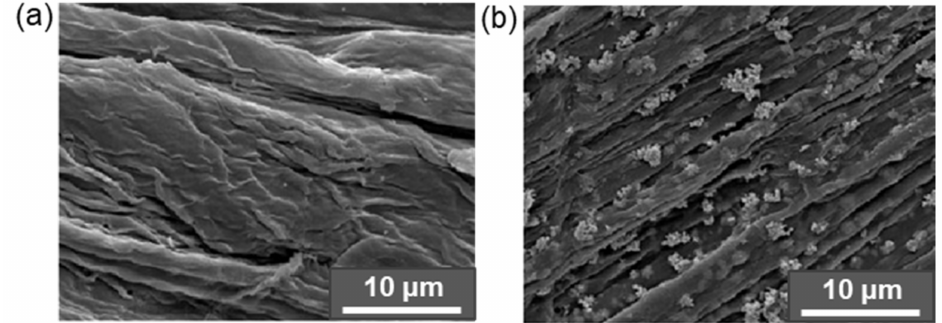
Figure 14. SEM images of neat CMC ( a ) and CMC modified with Ag nanoparticles ( b ). Reproduced from [245] with permission of